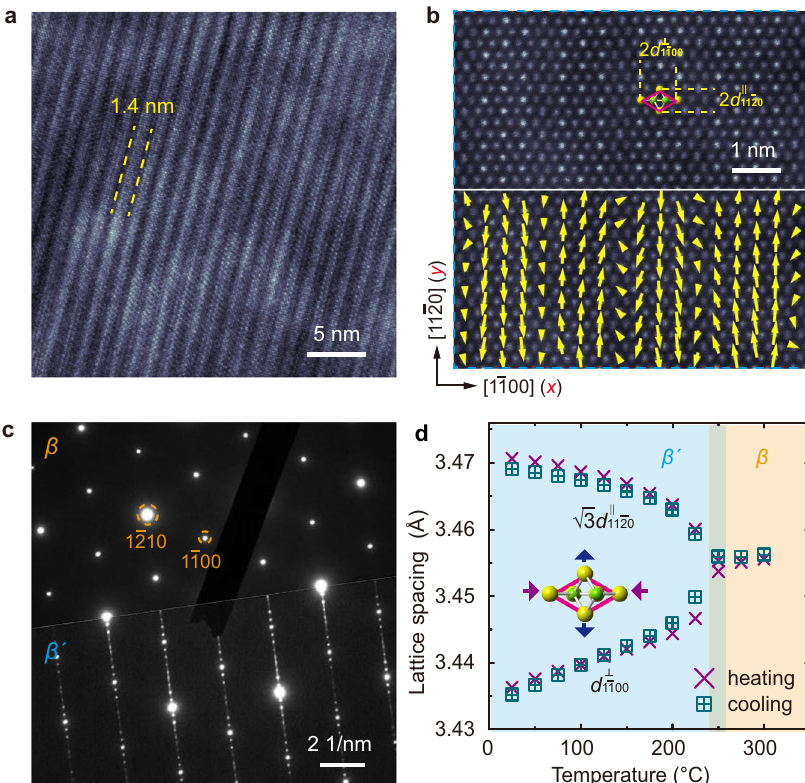
Fig. 1 Antiferroelectricity-coupled spontaneous strain in β ’ -In 2 Se 3 . a TEM image showing the characteristic nanostriped superstructure in 2H β ’ -In 2 Se 3 . b Atomic-resolution annular dark- fi eld (ADF) STEM image of the nanostripes and the atomic displacement map showing antiferroelectric ordering. c Selected-area electron diffraction (SAED) patterns of the parent β (top) and the room-temperature β ’ (bottom) phases. The nanostriped superstructure in β ’ -In n /8 1 (cid:1) 100 corresponding to the characteristic nanostripe width of 4 d 2 Se 3 gives rise to satellite diffraction at a function of temperature extracted from in situ XRD for both heating and cooling processes. The observed increase of β -to- β ’ transition re fl ect the anisotropic spontaneous strain with lattice dilation (compression) along (perpendicular to) the β ’ -In